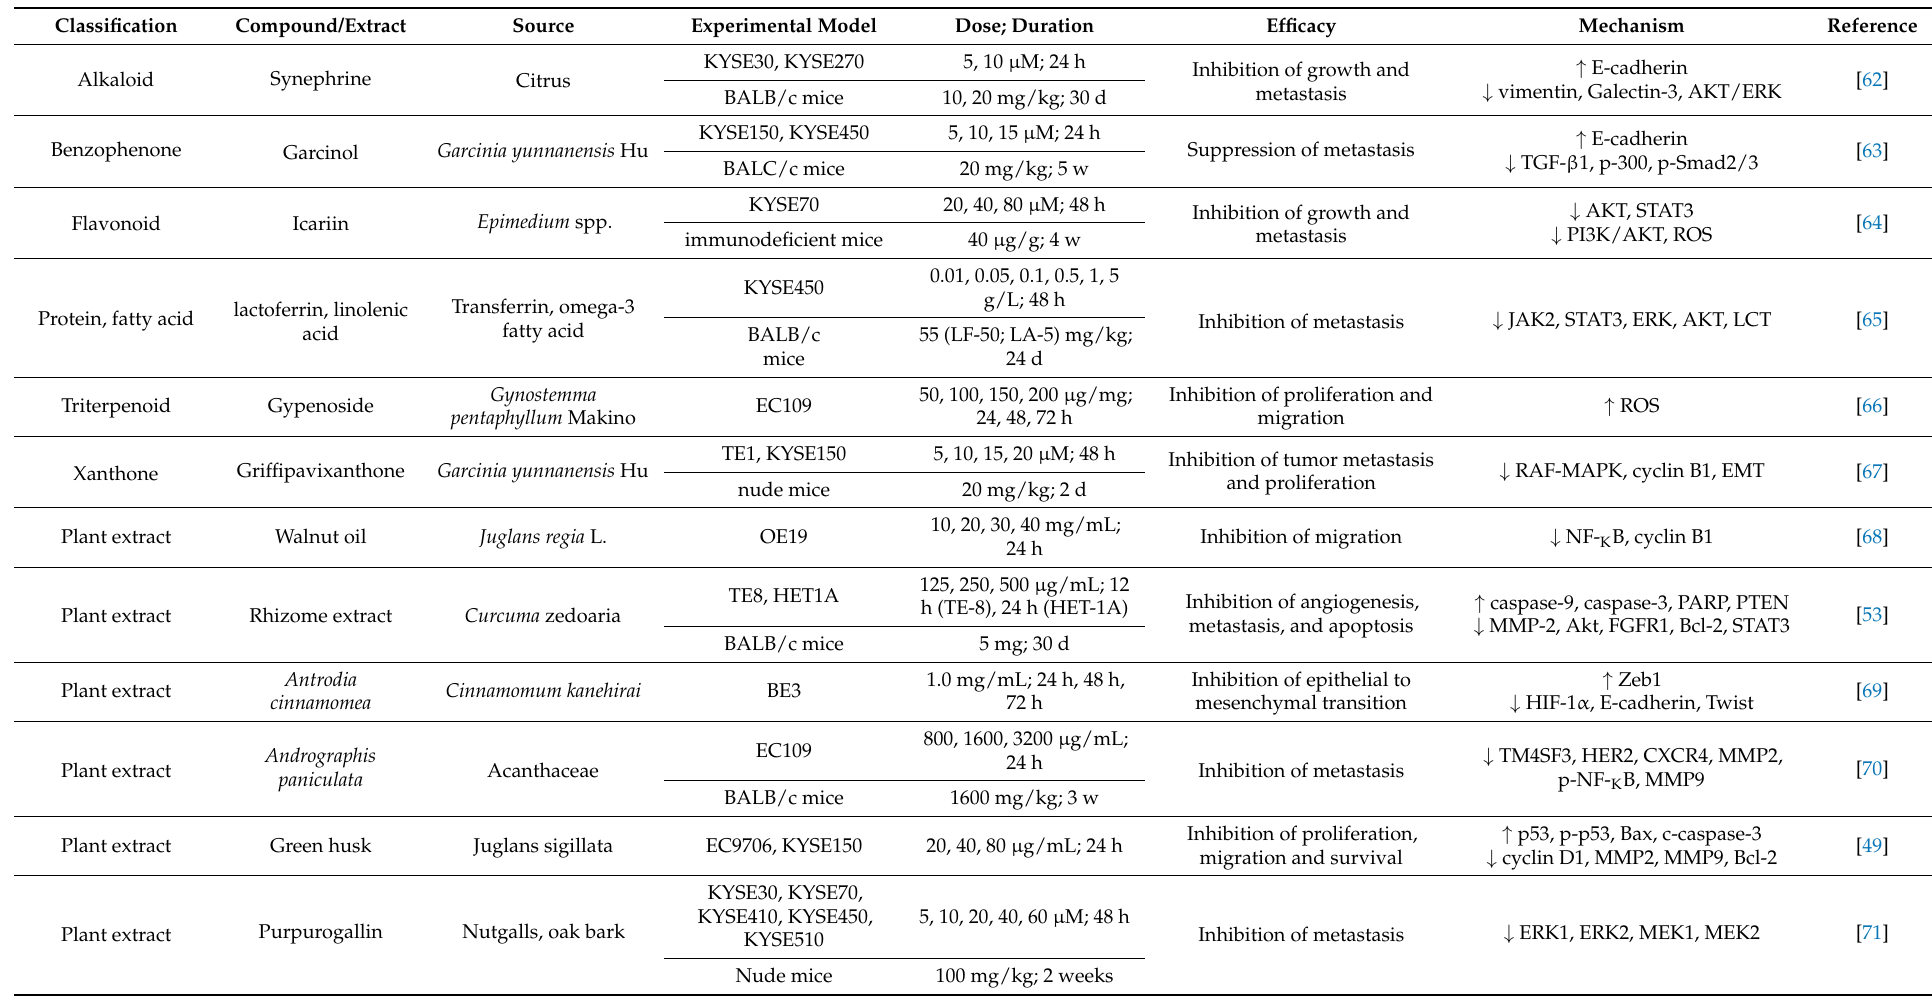
Table 3. Anti-metastasis-related natural